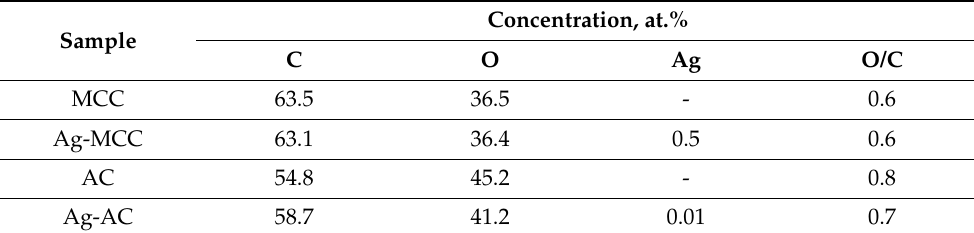
Table 5. Elemental composition of the cellulose-based composites.